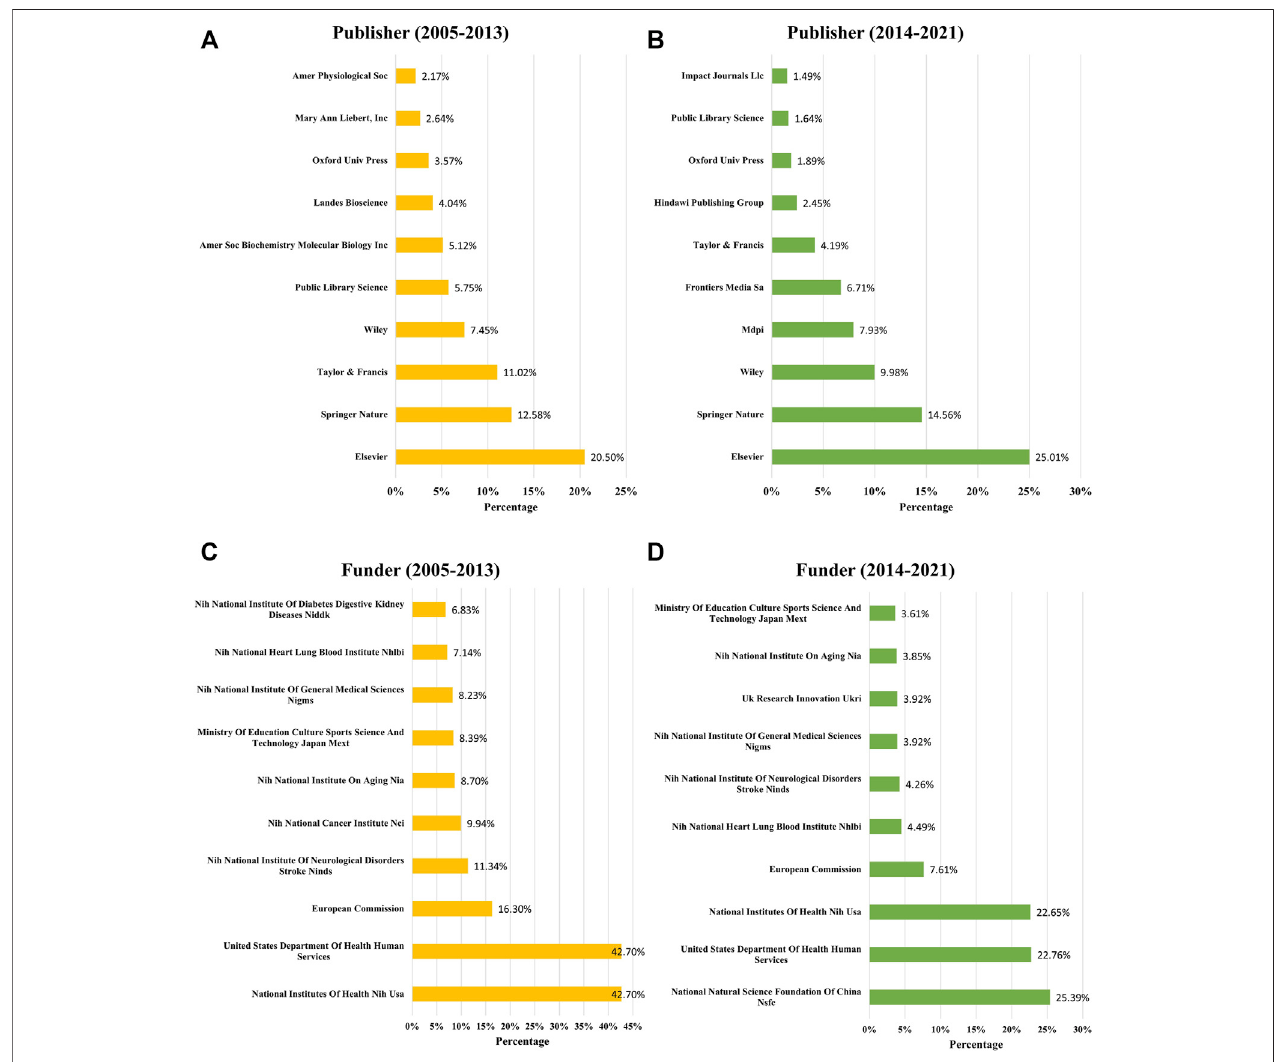
FIGURE6| Publishersandfunderschangesformitophagyresearch.Top10publisherswiththelargestnumberofarticlesonmitophagyduring2005 – 2013 (A) and 2014 – 2021 (B) . Top 10 funders sponsored the largest number of publications during 2005 – 2013 (C) and 2014 – 2021 (D)